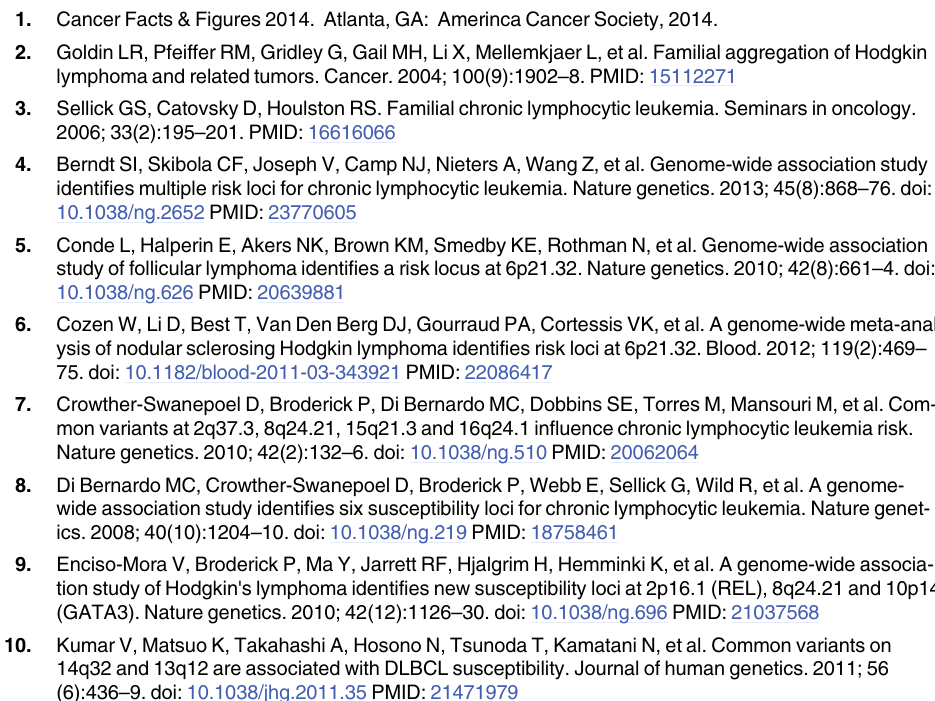
S11 Table. Summary of lymphoma risk SNPs. Summary of all original lymphoma & CLL SNPs and their LD partners, along with information on whether or not any of these SNPs were found to be in DNase hypersensitivity sites, active promoters (for both ChromHMM and Seg- way), or strong enhancers (ChromHMM and Segway). All of the tracks are for GM12878. The final column describes the eQTL status of the as seen in Westra et